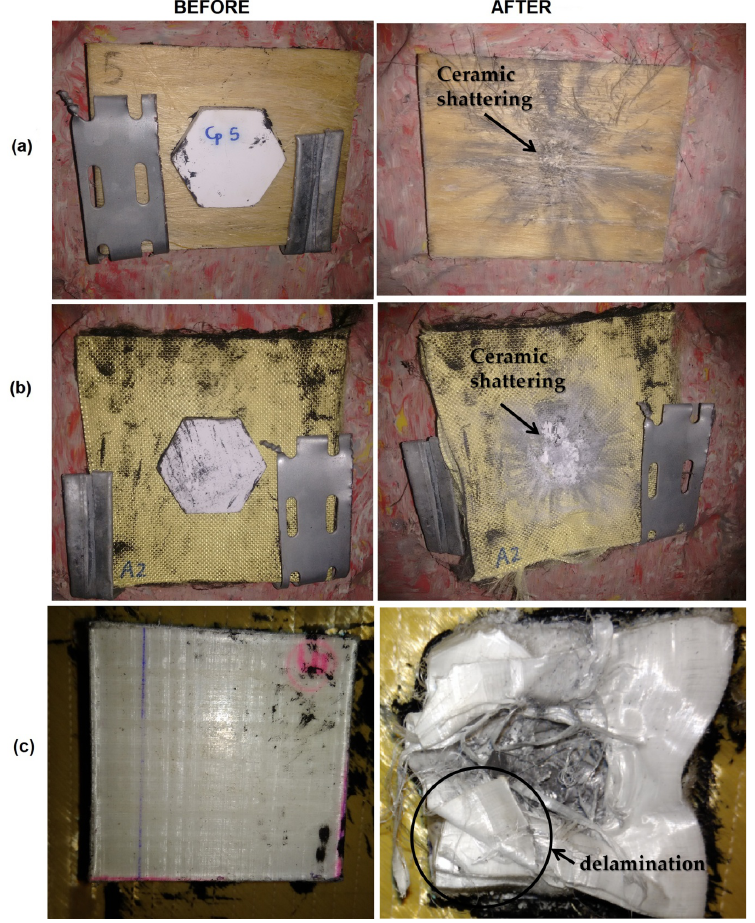
Figure 7. Armor plates before and after the ballistic test. The ceramic/PALF composite system ( a ), A single layer of ceramic ( b ), and a Dyneema plate ( c ).